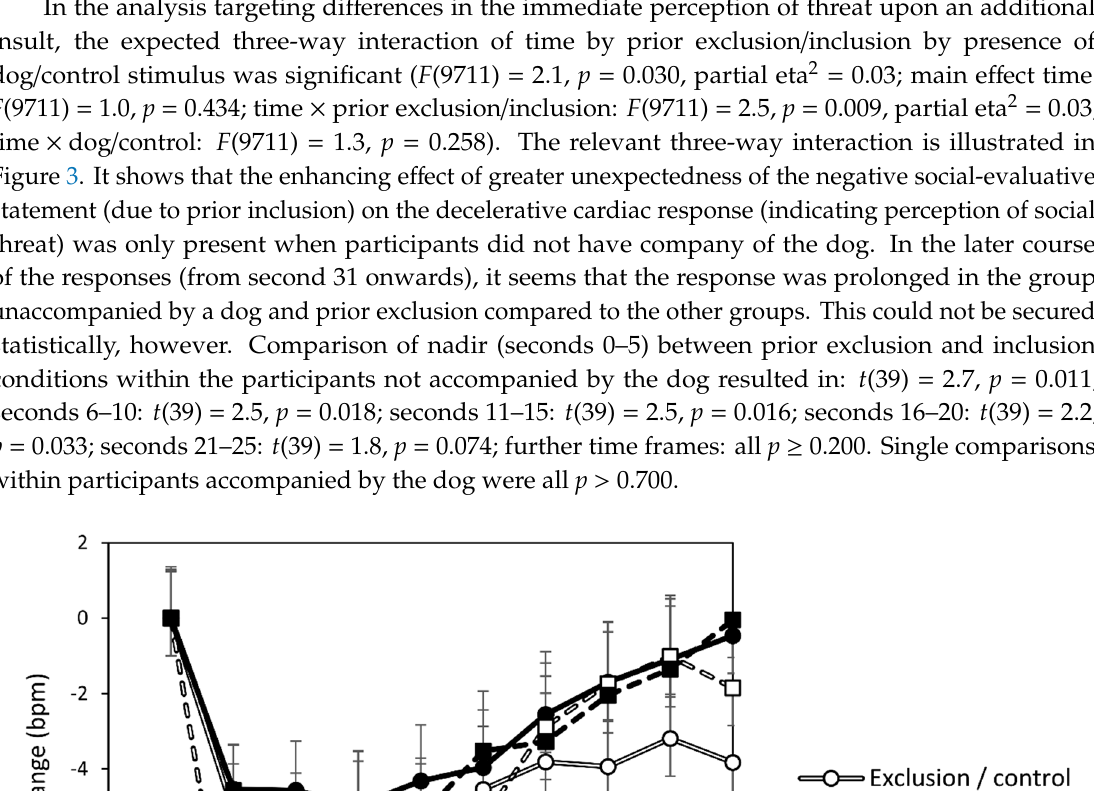
Figure 3. Immediate cardiac response to later insulting social-evaluative statement. Significant interaction effect of prior exclusion/inclusion by presence of dog/control stimulus by time. The essential difference is in the early part of the response (seconds 0–15). The offending statement occurred at second zero. Whiskers denote standard errors.